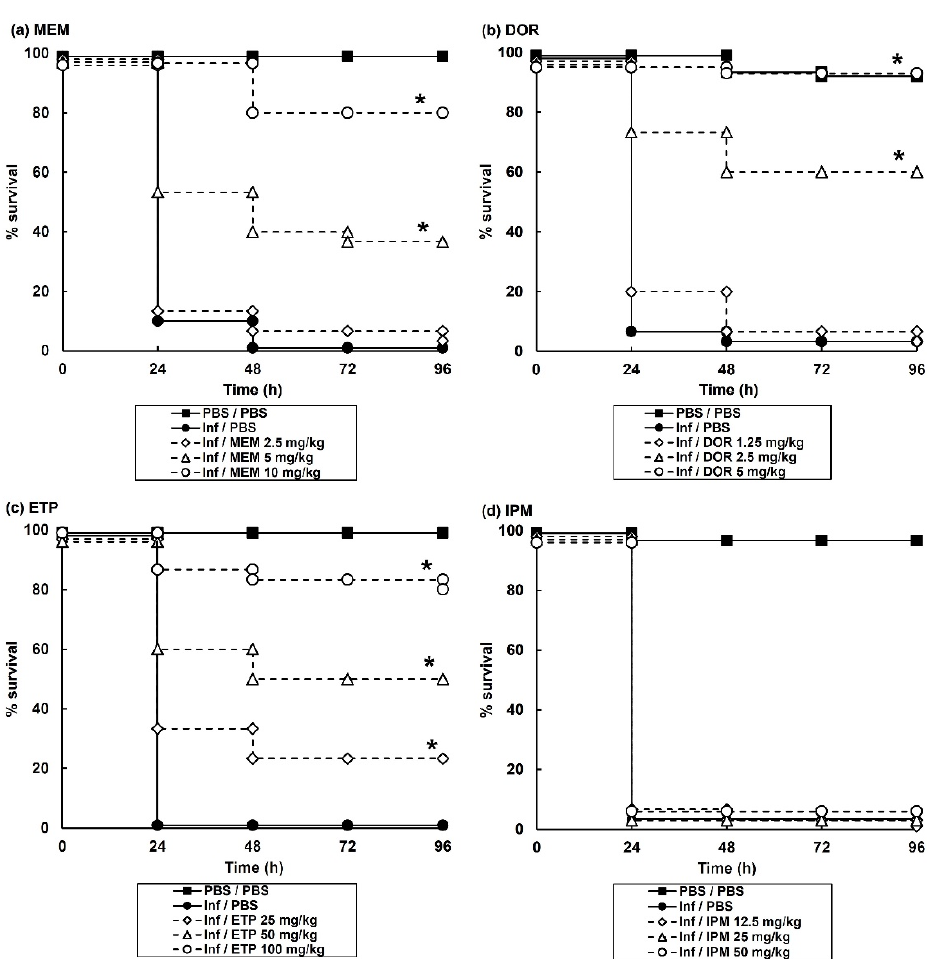
Figure 1. Effect of treatment with carbapenem monotherapies on survival of G. mellonella larvae infected with 2.5 × 10 3 cfu/mL P. aeruginosa NCTC13437. Infected larvae were treated with PBS (mock ‘treated’), or: ( a ) MEM (2.5, 5 or 10 mg/kg); ( b ) DOR (1.25, 2.5 or 5 mg/kg); ( c ) ETP (25, 50 or 100 mg/kg); ( d ) IPM (12.5, 25 or 50 mg/kg) and incubated at 37 °C for 96 h. A single dose of the antibiotic treatments was administered 2 h p.i. The uninfected group represents larvae sham-infected with sterile PBS and treated with sterile PBS. * Indicates significantly enhanced survival compared to infected larvae treated with PBS ( p < 0.05, log rank test with Holm correction for multiple comparisons); n = 30 (pooled from duplicate experiments).